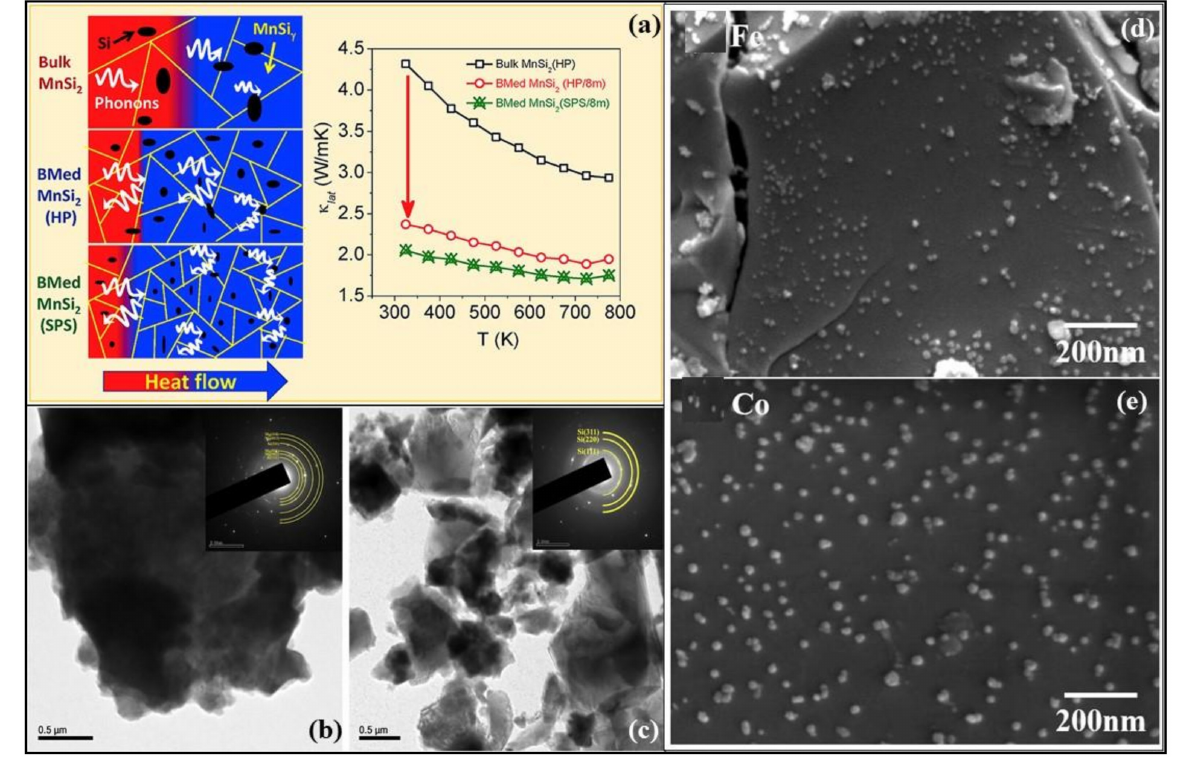
Figure 6. ( a ) Schematic illustration of scattered mid-to-long wavelength phonons by increased grain boundaries of bulk and ball milled (BM) higher manganese silicide embedded with silicon nanoparticles synthesized by hot uniaxial pressing (HP) and spark plasma sintering (SPS). Also, the temperature dependence of lattice thermal conductivities of bulk MnSi 2 (HP), ball-milled MnSi 2 (HP), and ball milled MnSi 2 (SPS) is shown, Reproduced with permission from [77]. Copyright © 2019, Elsevier, ( b , c ) TEM images of milled magnesium-silicon mixture and silicon-germanium alloy powder, Reproduced with permission from [78]. Copyright © 2018, Elsevier, ( d , e ) SEM images of iron (Fe) and cobalt (Co) nanoparticles in the hybrid powder of MnSi 1.787 Al 0.01 , Reproduced with permission from [79]. Copyright © 2020,